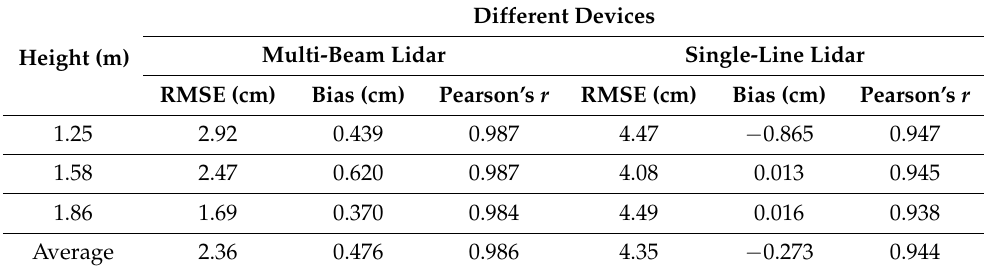
Table 2. Accuracy assessment for DBH parameter.